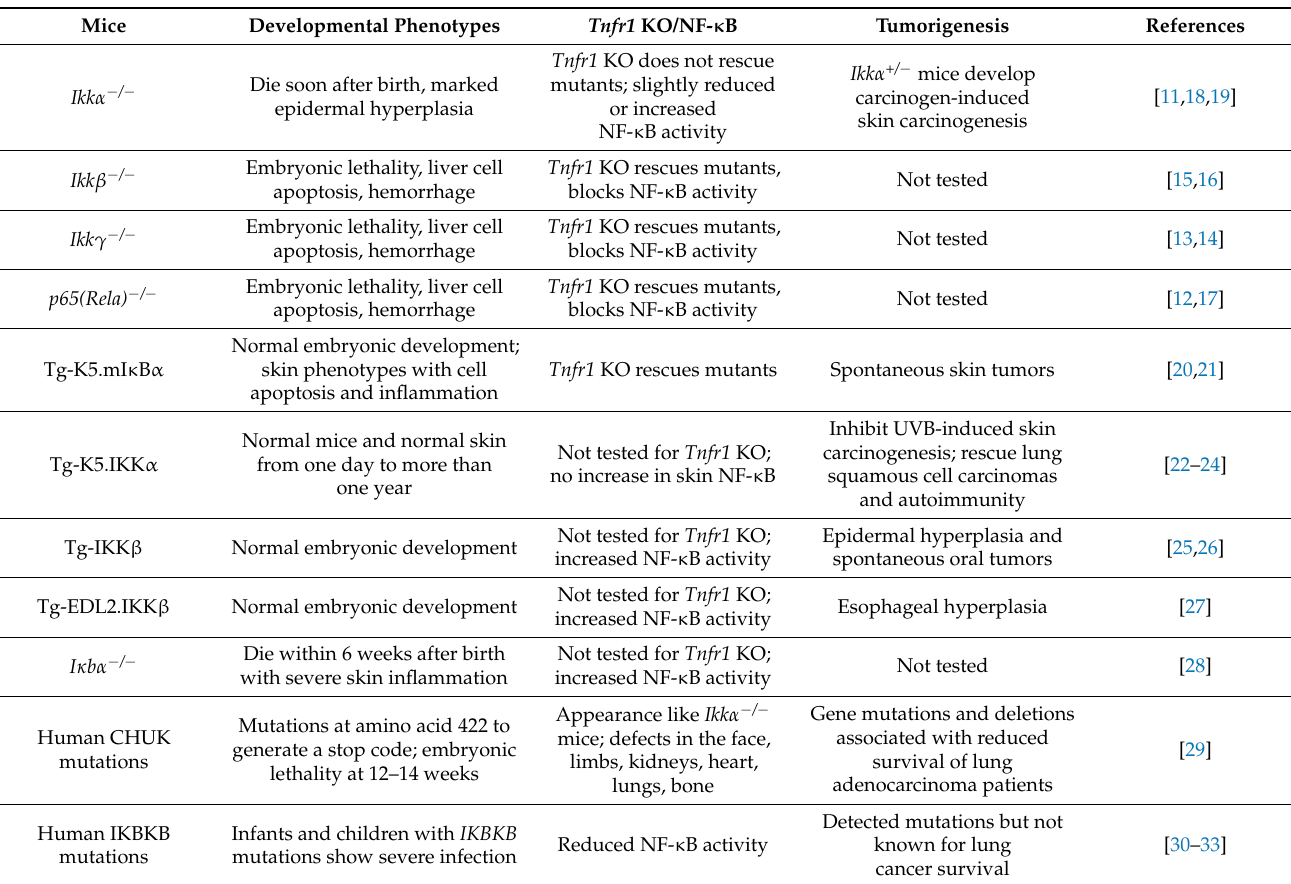
Table 1. Comparison of physiological activities and IKK/NF- κ B activities in genetically modified mice and humans.